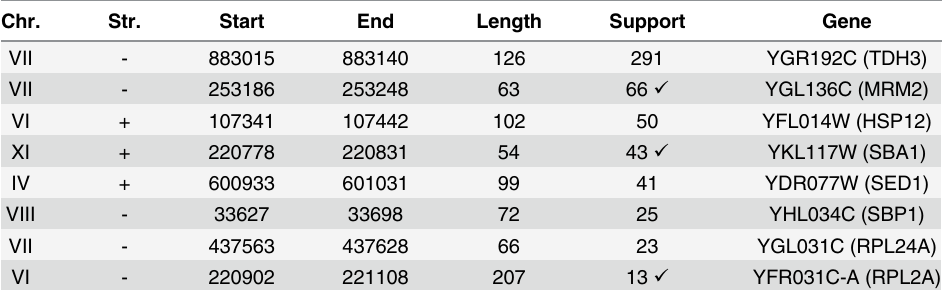
Both, the unspliced and spliced transcript isoform can yield protein products. The table shows the chromosome (Chr.), strand (Str.), Start and End of the intron, as well as intron Length, read support for the novel (i.e. spliced) isoform and the affected Gene. Check marks indicate successful validation in the independent dataset.